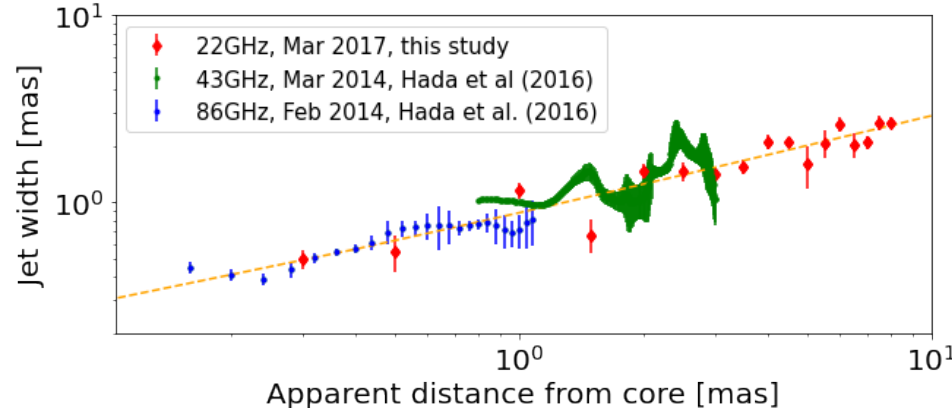
Figure 4. The width of the jet relative to the apparent distance from the core is shown on a double- logarithmic graph. Red diamonds show the result of this study. Green and blue circles are obtained from 43 and 86GHz images, respectively, observed with VLBA and GBT in 2014 [6]. The best-fit model ( W ∝ r 0.54 ± 0.09 ) for the relationship between the apparent distance r and jet width W , obtained from the images of this study, is shown with an orange dashed line. The observation epochs are noted in the